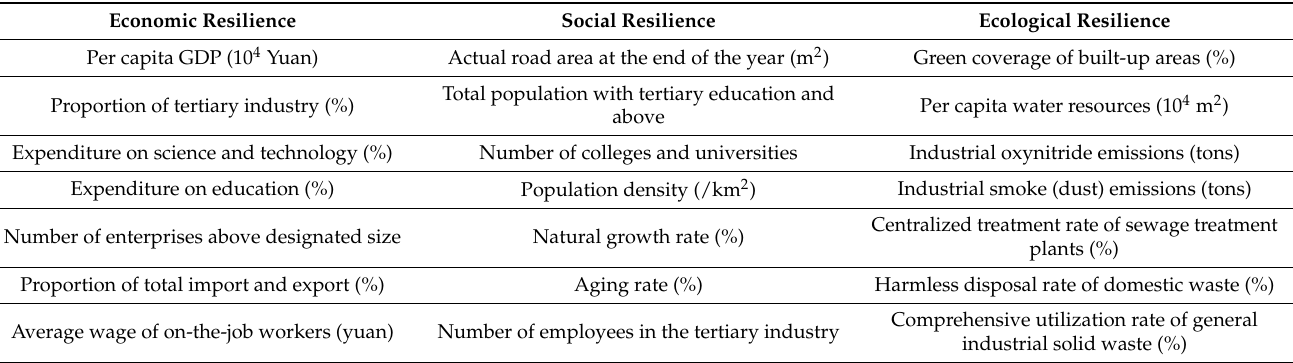
Table 1. Evaluation index